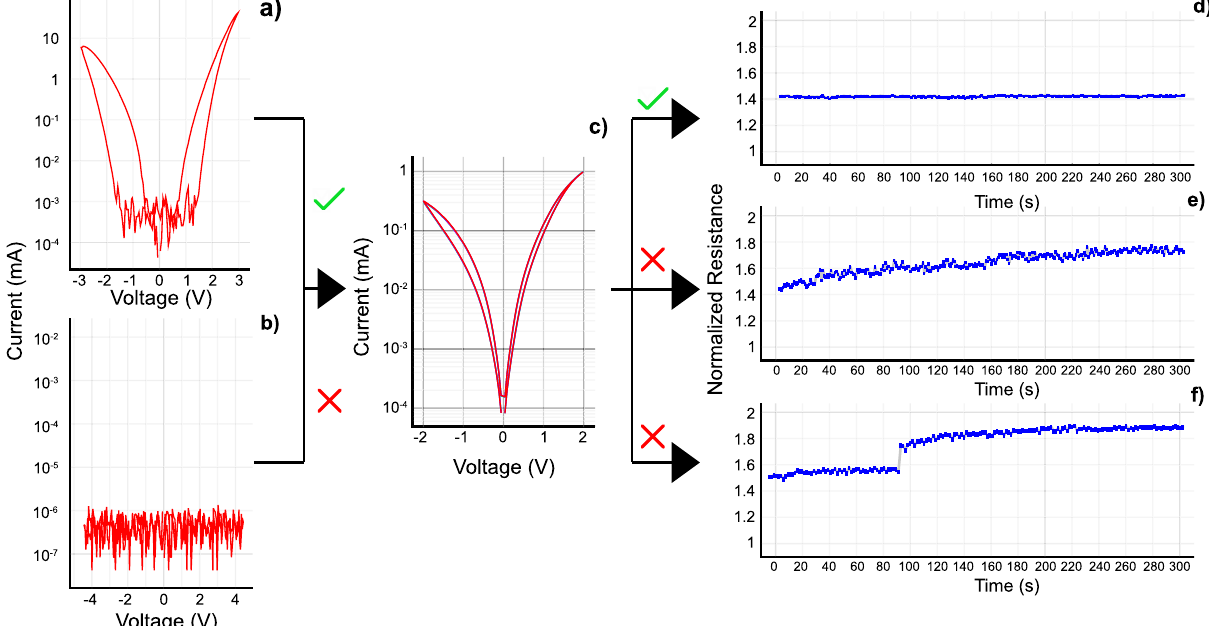
Figure 1. Pristine devices might exhibit a specific signature behavior, declaring them fit for use. Subfigure ( a ) is a representative case of a working pristine device, where a hysteretic loop ,either unilaterally or bilaterally, is an indication of formability. Subfigure ( b ) represents a device which is not available for forming, indicated by the noisy signature. Subfigure ( c ) presents a working device which results from electroforming a device with a typical working pristine signature. Subfigure ( d ) exhibits an acceptable post forming retention test. Devices which exhibit either a volatile behaviour, subfigure ( e ), or sudden instabilities, subfigure ( f ), are discarded as non viable for testing. DC bias for all retention tests was kept stable at 0.5